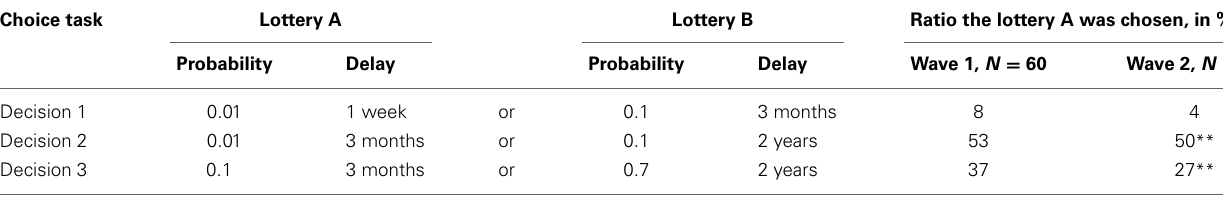
Table 3 | Results of the choice tasks in Study